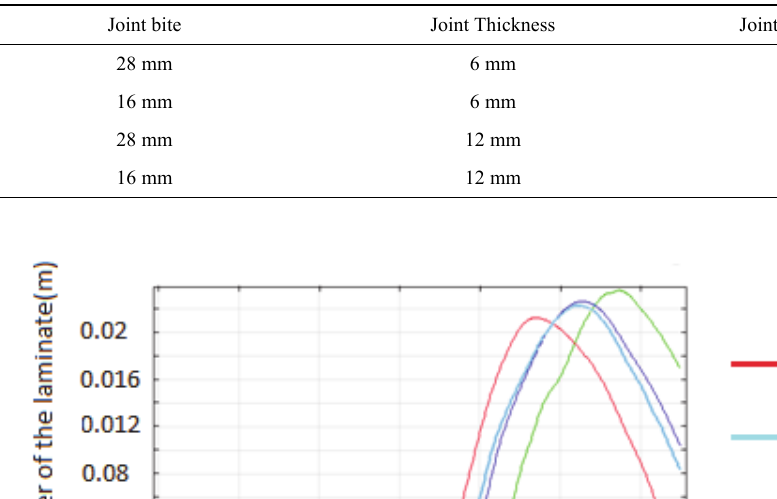
Table 3: Calculation of membrane deflection, variation the geometry of the structural joint attaching the laminate to the frame